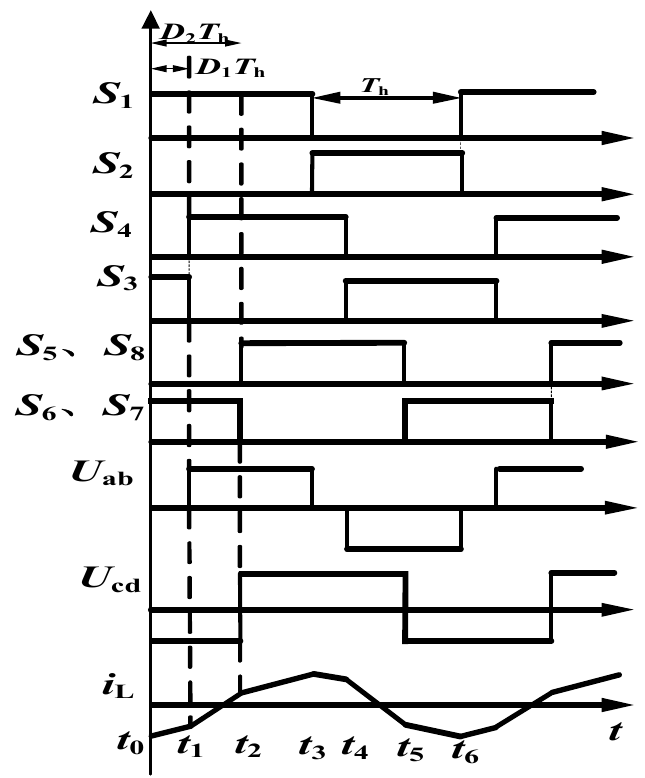
Figure 2. Waveforms of DPS control.